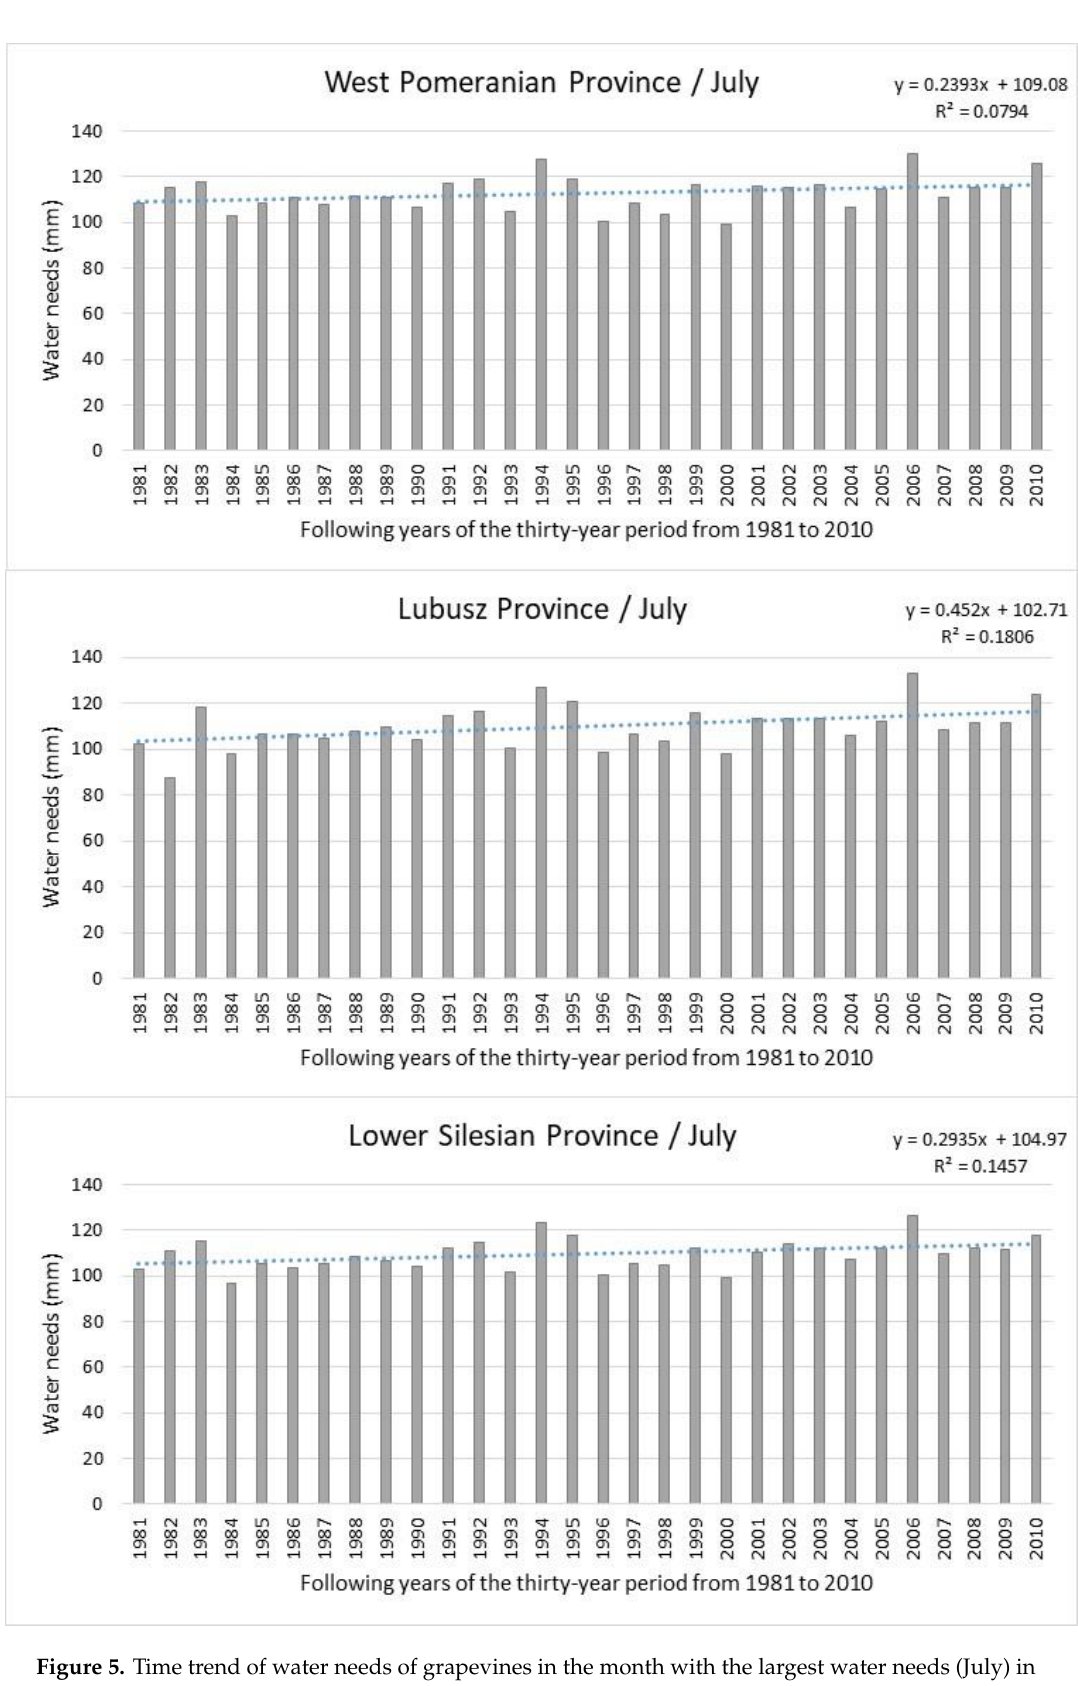
Figure 5. Time trend of water needs of grapevines in the month with the largest water needs (July) in 1981–2010 in the western provinces of Poland.